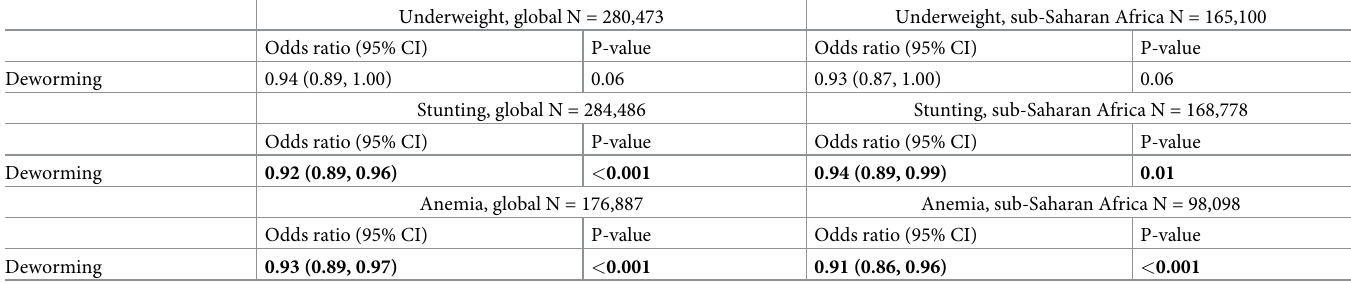
Table 3. Regression model estimating the relationship in health outcomes for pre-school age children reported to have received treatment for intestinal worms in past 6